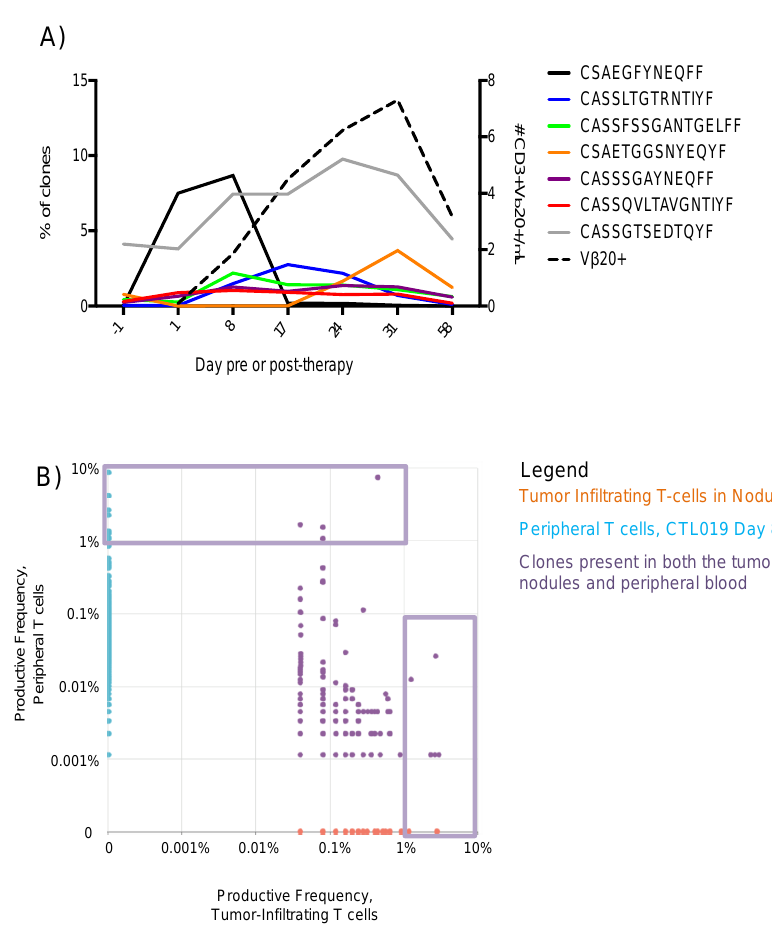
Figure 5. Transient expansion of T cell clones, present at high frequency within the tumor. ( A ): Deep sequencing of the TCRβ CDR3 regions as performed by Adaptive Biotechnologies (Seattle, WA, USA) on PBMCs collected one day prior to CAR T administration, then on post-infusion days 1, 8, 17, 24, 31, and 58. Deep sequencing data are presented as the productive frequency of clones containing the indicated amino acid sequences in the CDR3 region at each time point. The expansion of CAR T cells was determined by flow cytometry against antibody targeting the Vβ-20+ sequence in the CAR (dashed line). ( B ): Pair-wise scatter plot showing the productive frequency of the sum of frequencies of clones of T cells, based upon the CDR3 sequencing data. X-axis represents T cells collected from a scapular nodule on post-CAR day 10, while y-axis denotes peripheral blood collected on post-CAR day 8. The violet boxes denote preferential expansion of small numbers of T cell clones, denoted oligoclonal expansion.